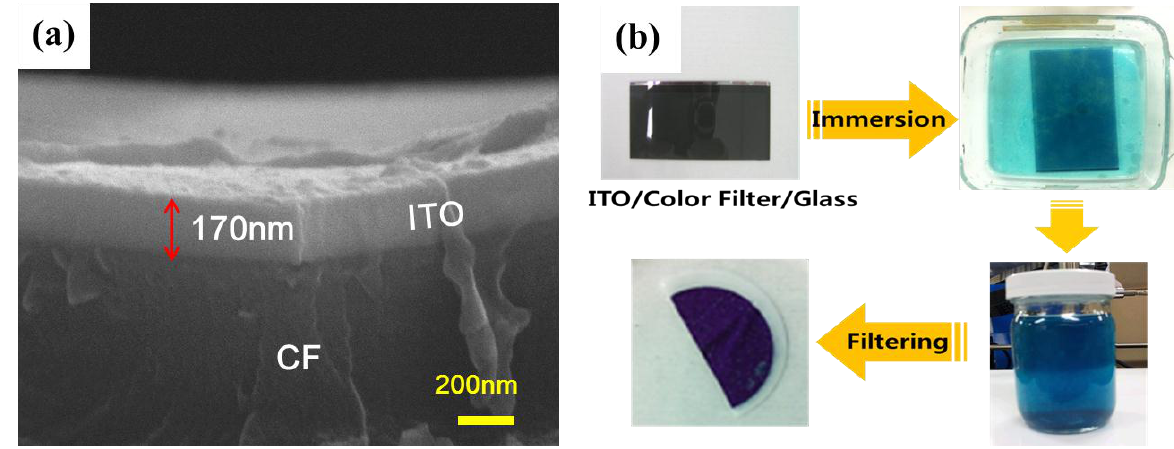
Figure 2. ( a ) SEM image of ITO taken from a car navigator; ( b ) schematic process for the recovery of